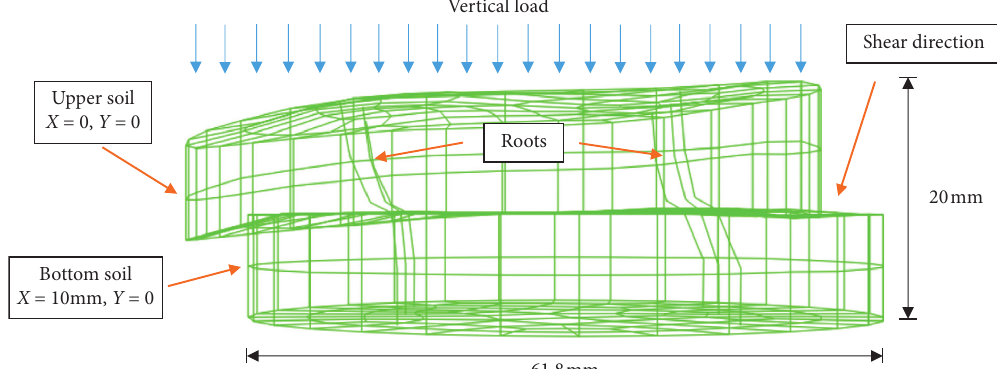
Figure 6: Numerical simulation of the laboratory direct shear